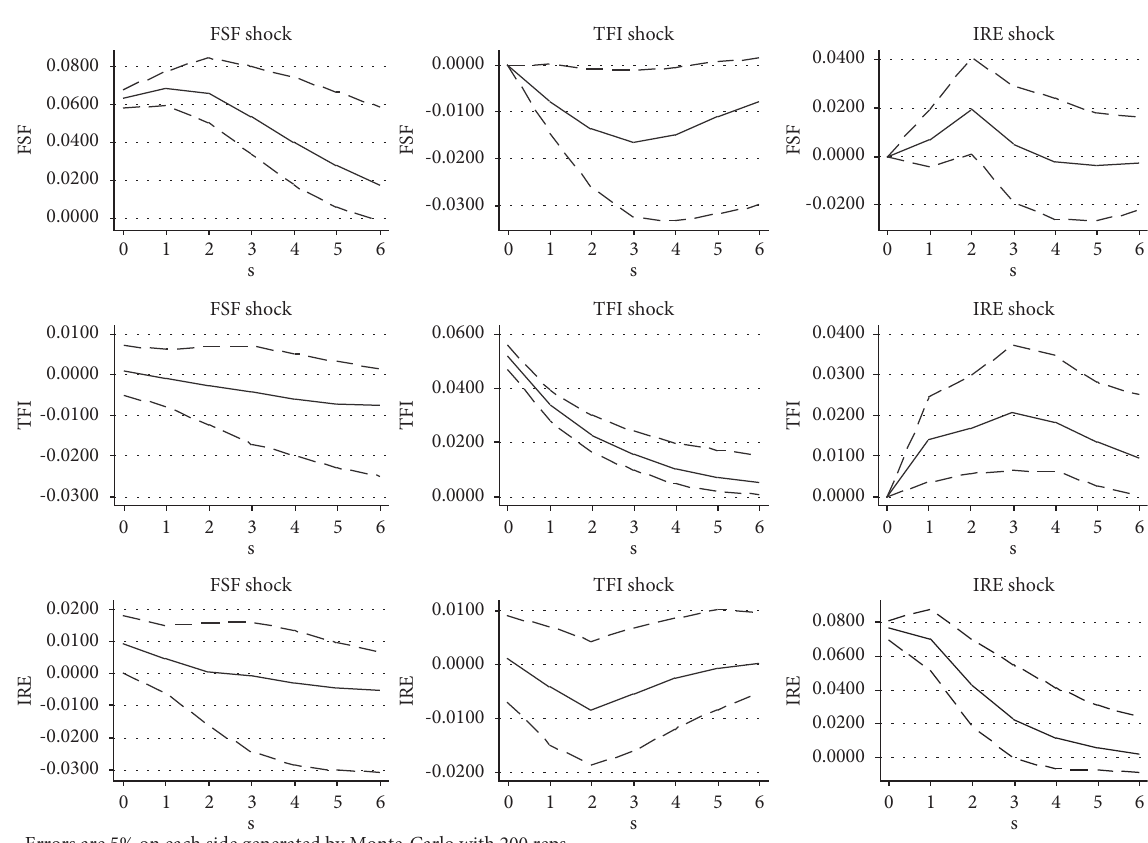
Figure 1: Pulse response graphs of gross national samples.